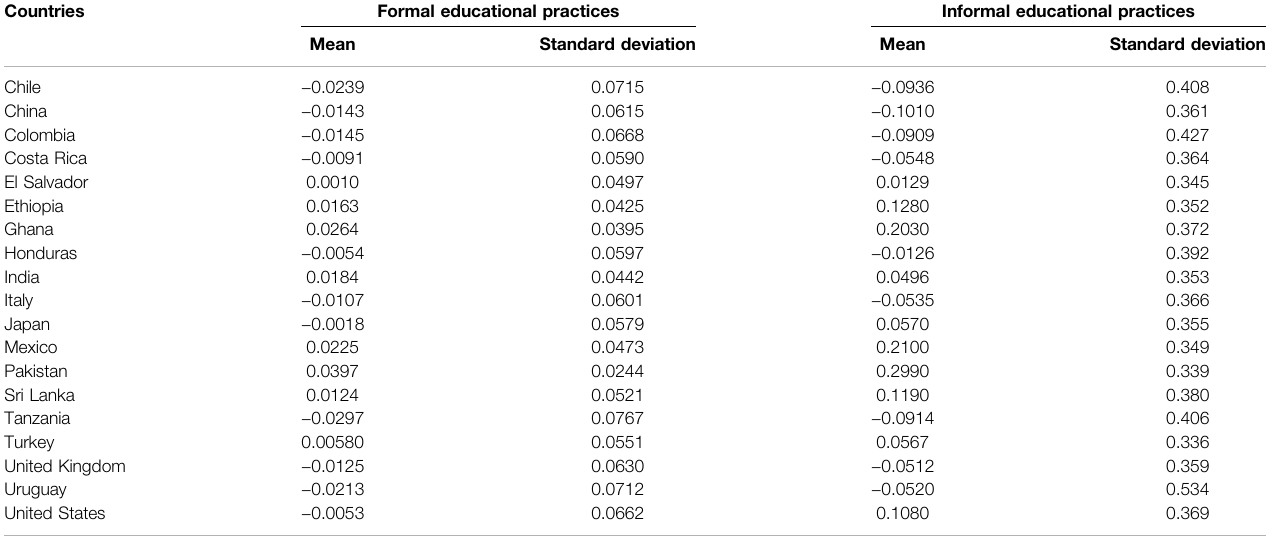
TABLE 3 | Descriptive statistics on parental involvement by country.